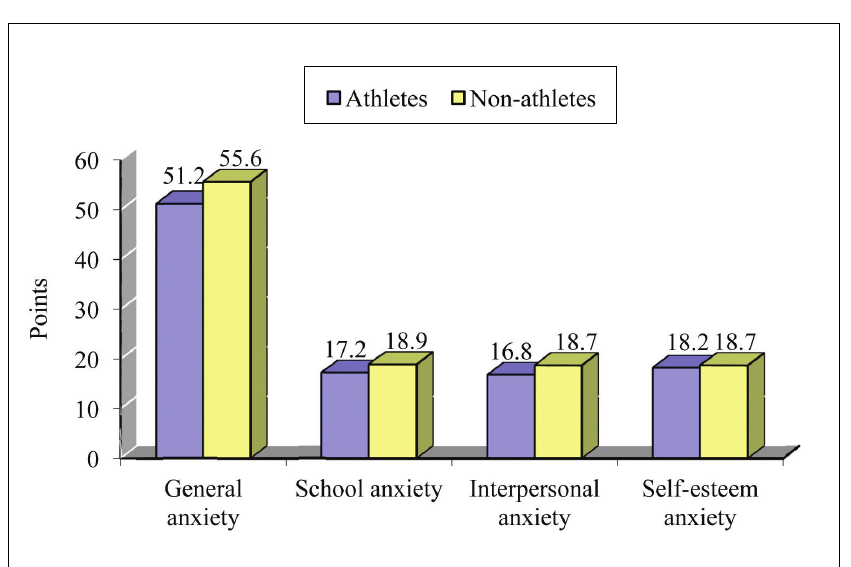
Figure 3. Anxiety evaluation of athlete and non-athlete adolescents (points)